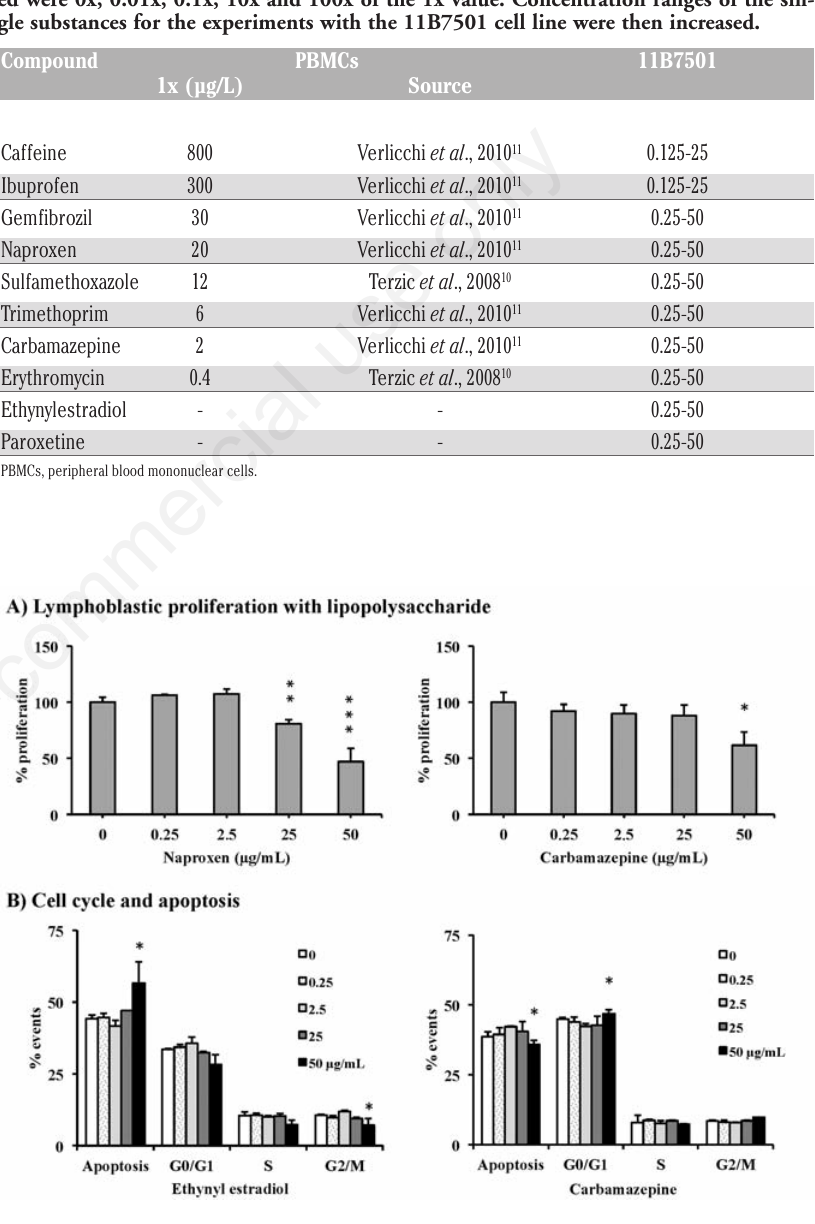
Figure 1. The lymphoblastic proliferation assay revealed significant effects for naproxen and carbamazepine (A). The cell cycle and apoptosis assay showed significant effects for ethynyl estradiol and carbamazepine (B). Significant differences are expressed by an aster- isk (*P<0.05, **P<0.01,